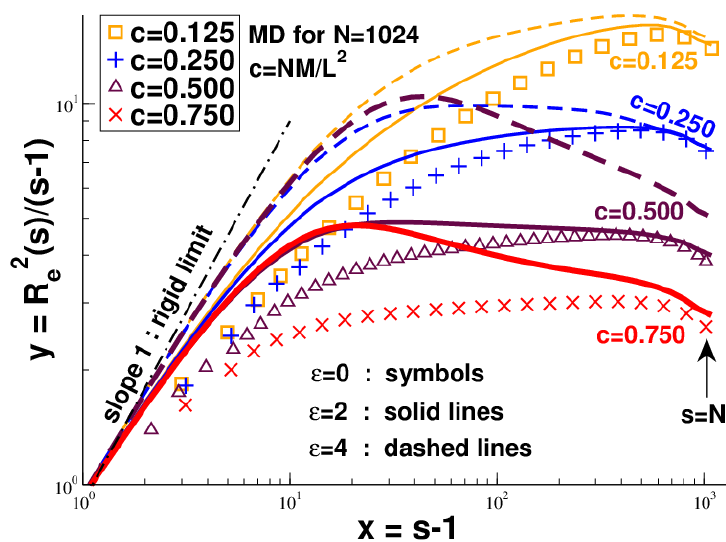
Figure 3. Rescaled sub-chain size y = R 2 e ( s ) / ( s − 1 ) with s being the arc-length (sub-chain length) for four concentrations and three stiffness penalties corresponding to systems below and around the dashed line in Figure 2. The symbols refer to flexible systems ( (cid:101) = 0); the line width for (cid:101) = 2 and 4 increases with density. The dash-dotted line corresponds to the asymptotic slope for perfectly rigid chains. Note that y ( s ) becomes strongly non-monotonous with increasing (cid:101) . However, for a given density and s → N , all y ( s ) become similar as long as the system remains isotropic, i.e., (cid:101) is not too large. Independent of the rigidity, the overall chain size is thus ruled by the (persistence length independent) distance d cm ≈ ( N / c ) 1/ D between